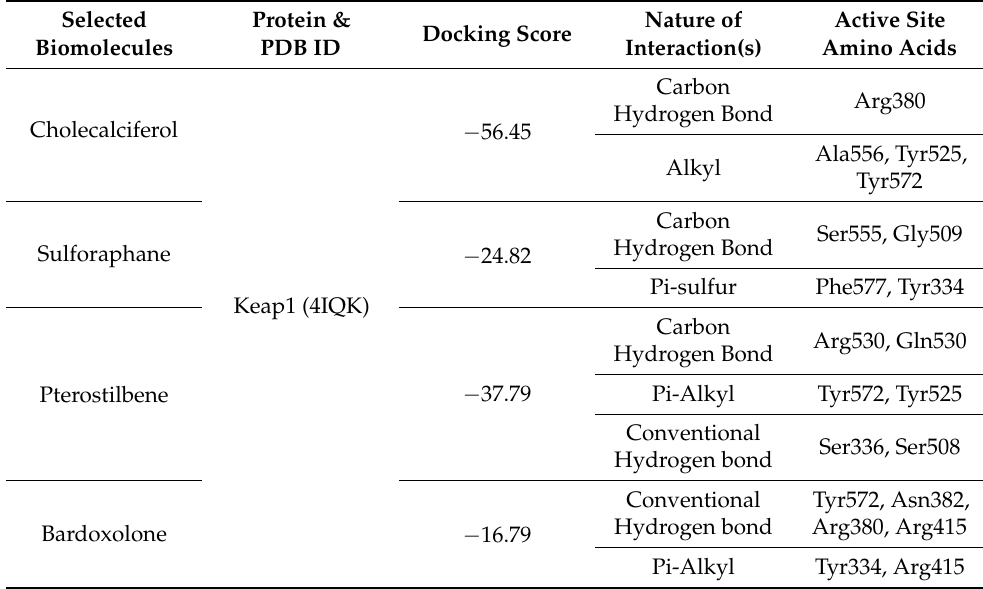
Table 2. Docking score, nature of interaction(s), and the key amino acids involved in binding of selected Nrf2